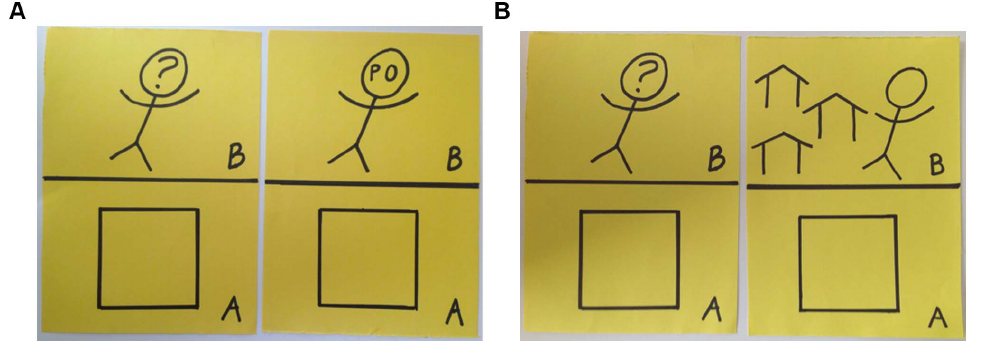
Figure 1. DG game boards for the PO member condition and co-villager condition. In both treatment conditions participants allocated one endowment between themselves and a stranger (identified by the question mark). The identity of the second recipient, however, varied across experimental conditions.